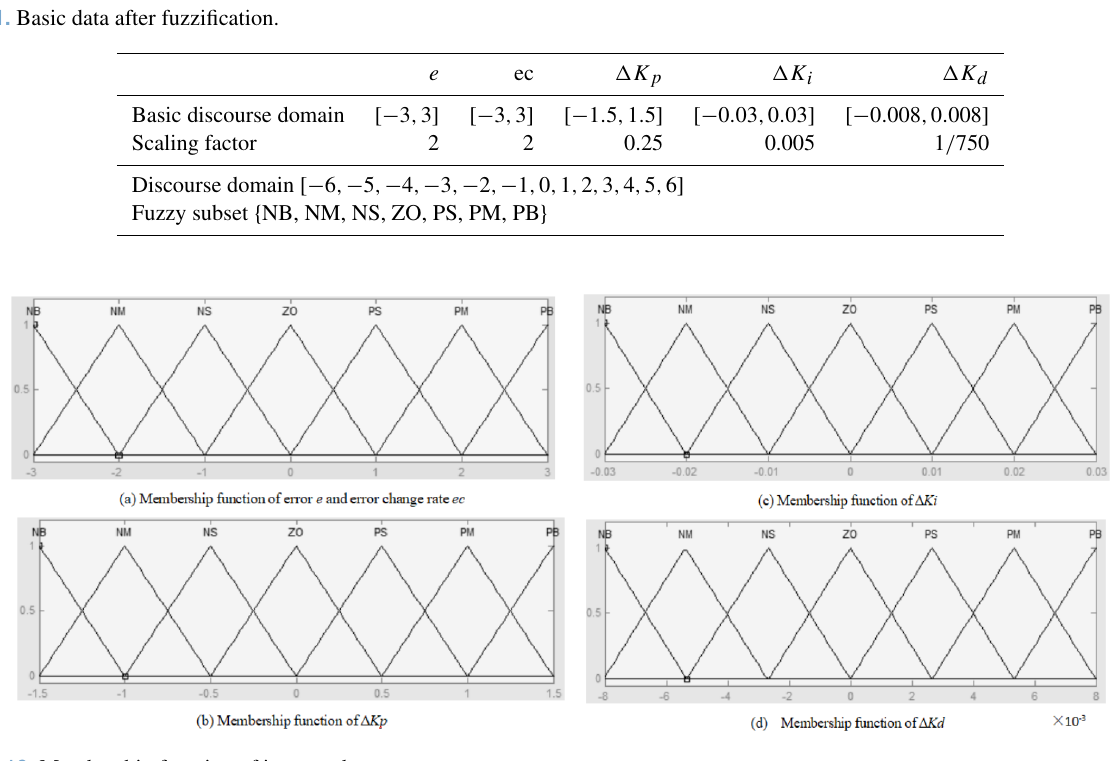
Figure 10. Membership function of input and output.